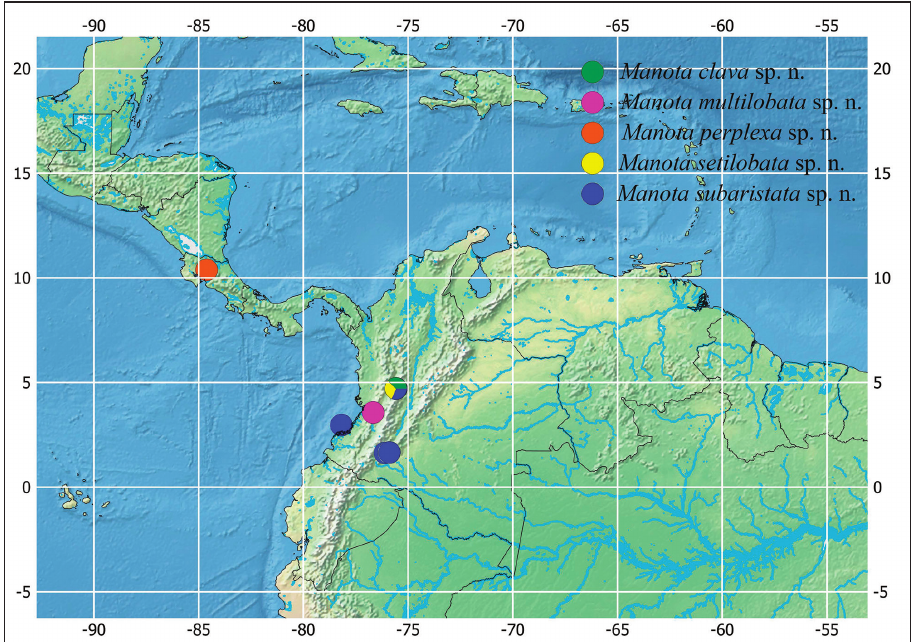
Figure 6. Distribution of the new species of Manota